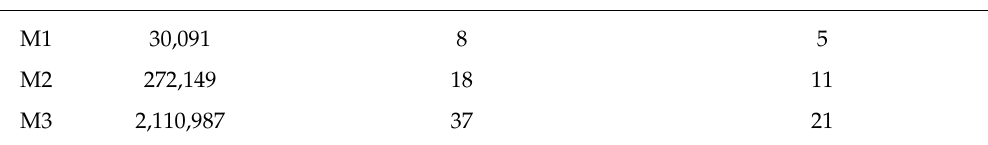
Table 10. openInjMoldSim meshes employed in Case Study